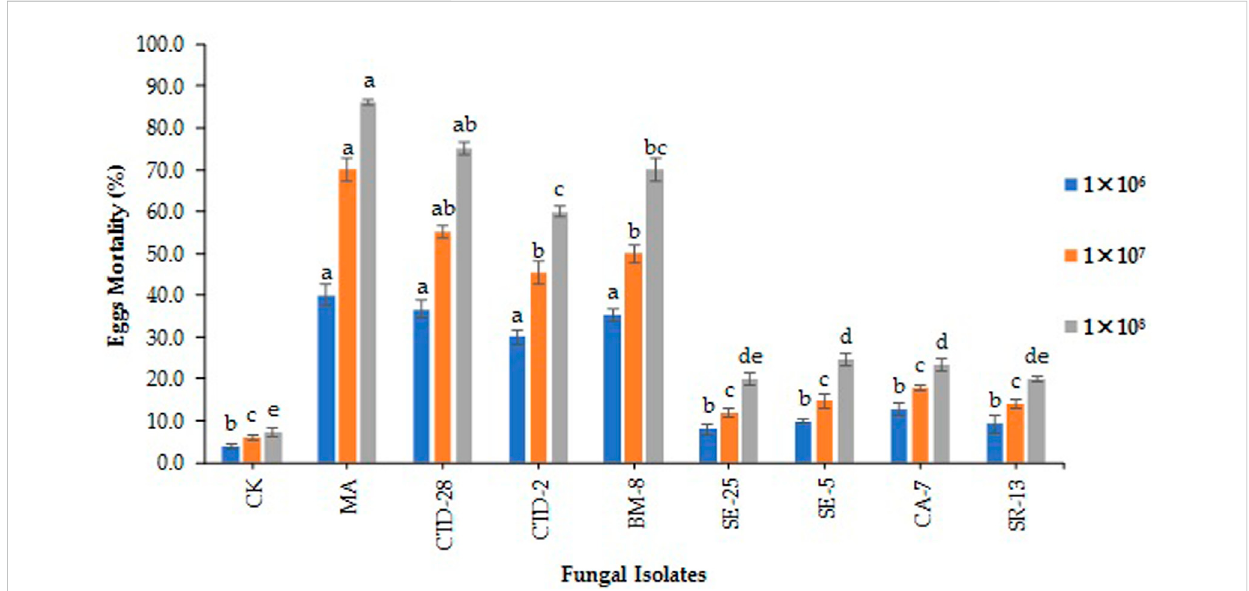
FIGURE 1 Fungal isolates induced fall armyworm ’ s egg mortality treated with different concentrations at 7 days post treatment. Error bars denote the mean ± standard error at the 95% con fi dence interval. Means followed by the same letters are not signi fi cantly different by Tukey ’ s test at p <